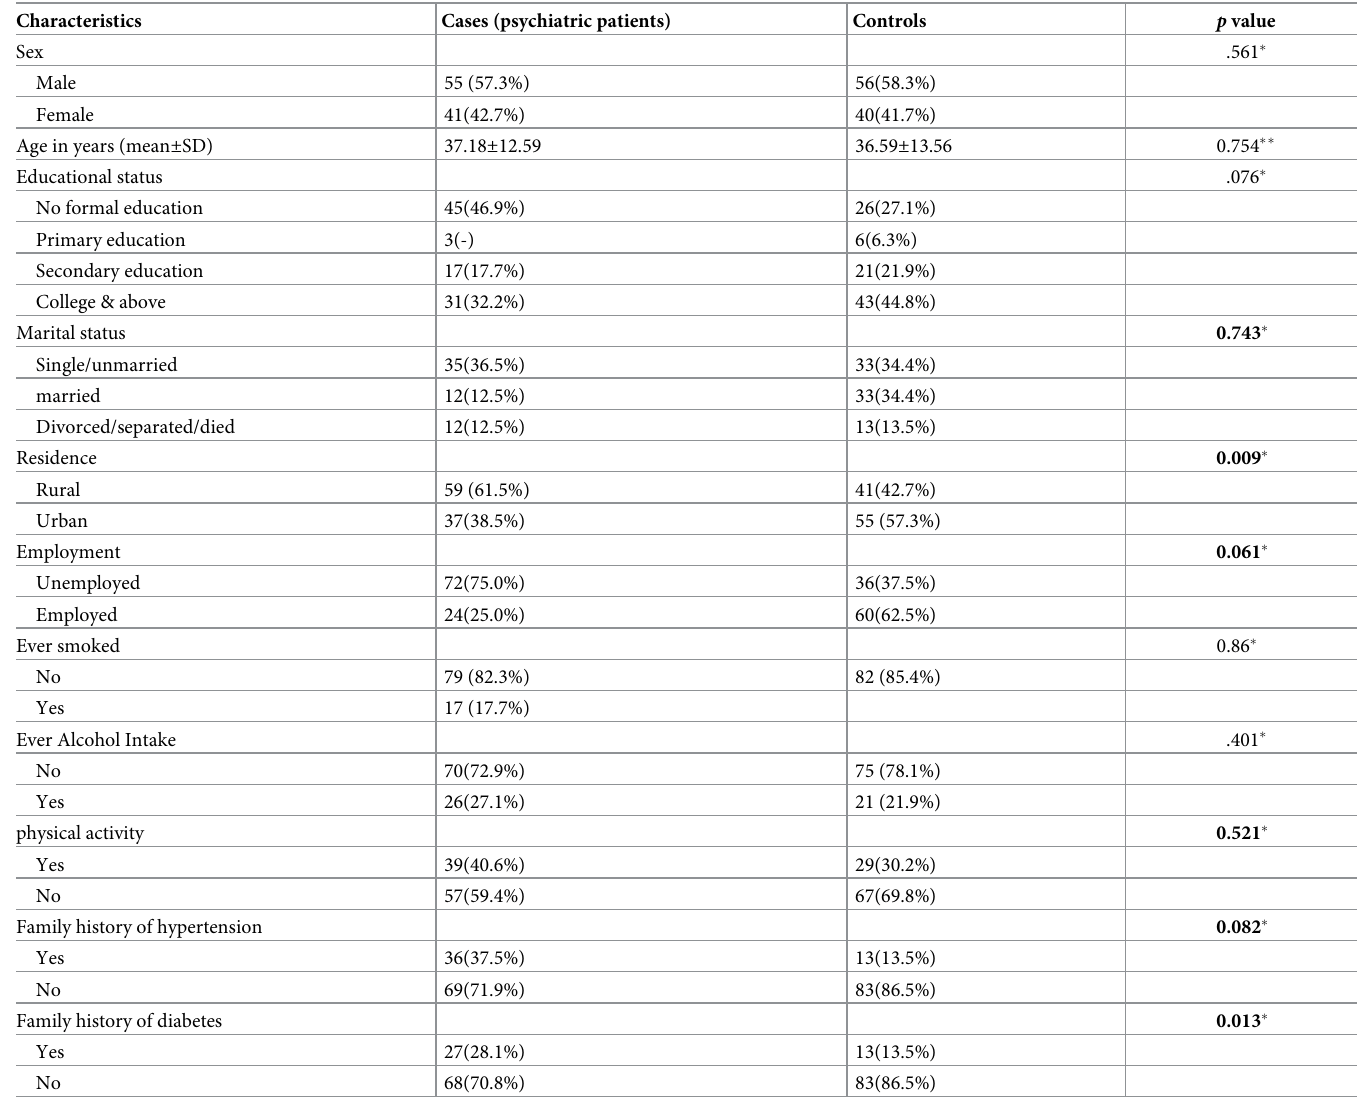
Table 1. Sociodemographic characteristics of psychiatric and non-psychiatric controls, Dire Dawa, Eastern Ethiopia 2021.